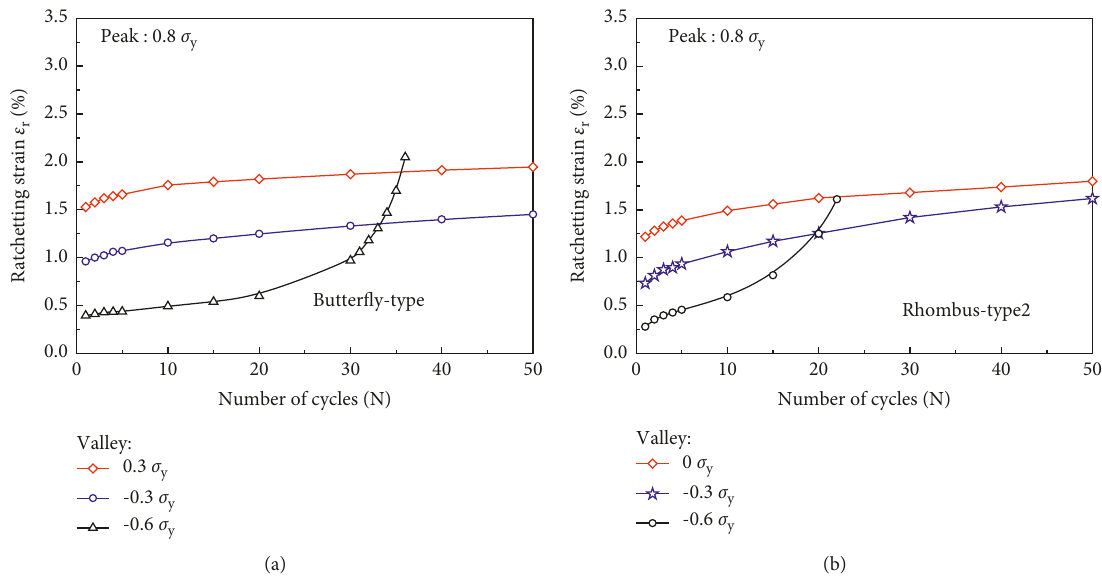
Figure 8: Ratchetting of PC in multiaxial stress-controlled cyclic tests with different valley stresses at a constant peak stress of 0.8 × σ with different loading paths: (a) butterfly-type; (b) rhombus-type